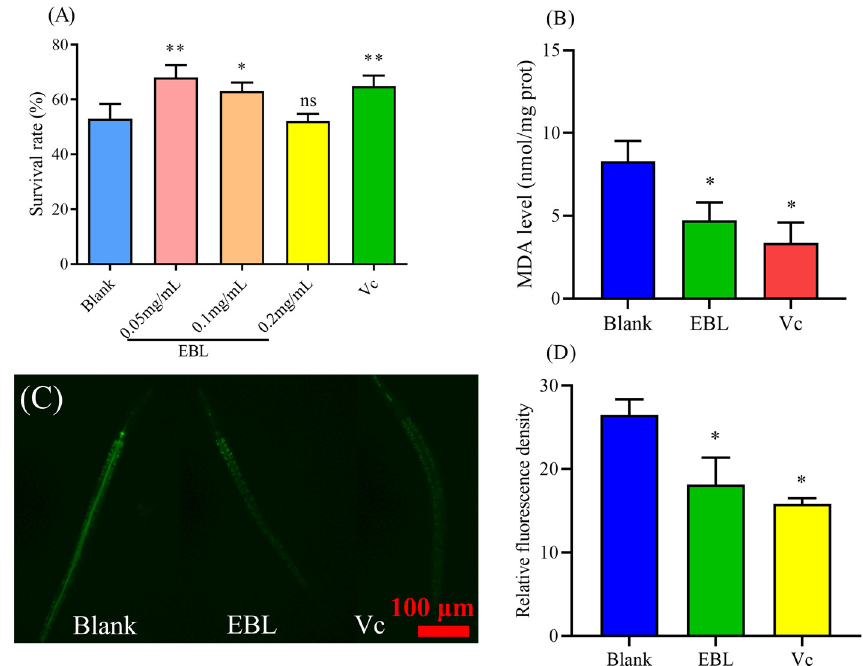
Figure 2. The impact of EBL on ( A ) the survival rate of C. elegans , ( B ) the content of MDA, ( C ) the level of ROS under thermal stress, and ( D ) the relative fluorescence density of ROS in C. elegans . The concentration of EBL for the determination of MDA and ROS was 0.1 mg/mL, considering the results of lifespan assays where only 0.1 mg/mL of EBL extended the lifespan of C. elegans . Vc meant ascorbic acid (10 µ g/mL). Notes: * and ** meant p < 0.05 and p < 0.01, respectively. Additionally, ns meant not significant.